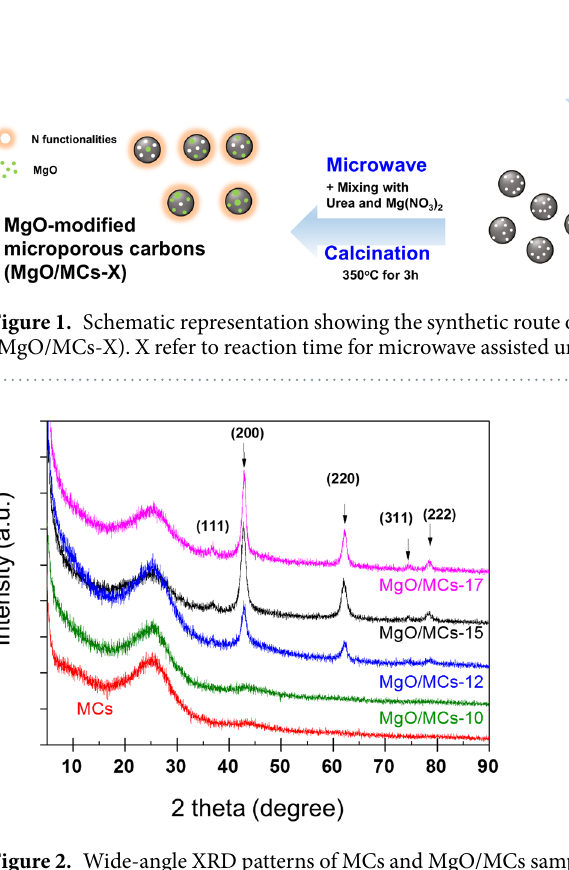
Figure 2. Wide-angle XRD patterns of MCs and MgO/MCs